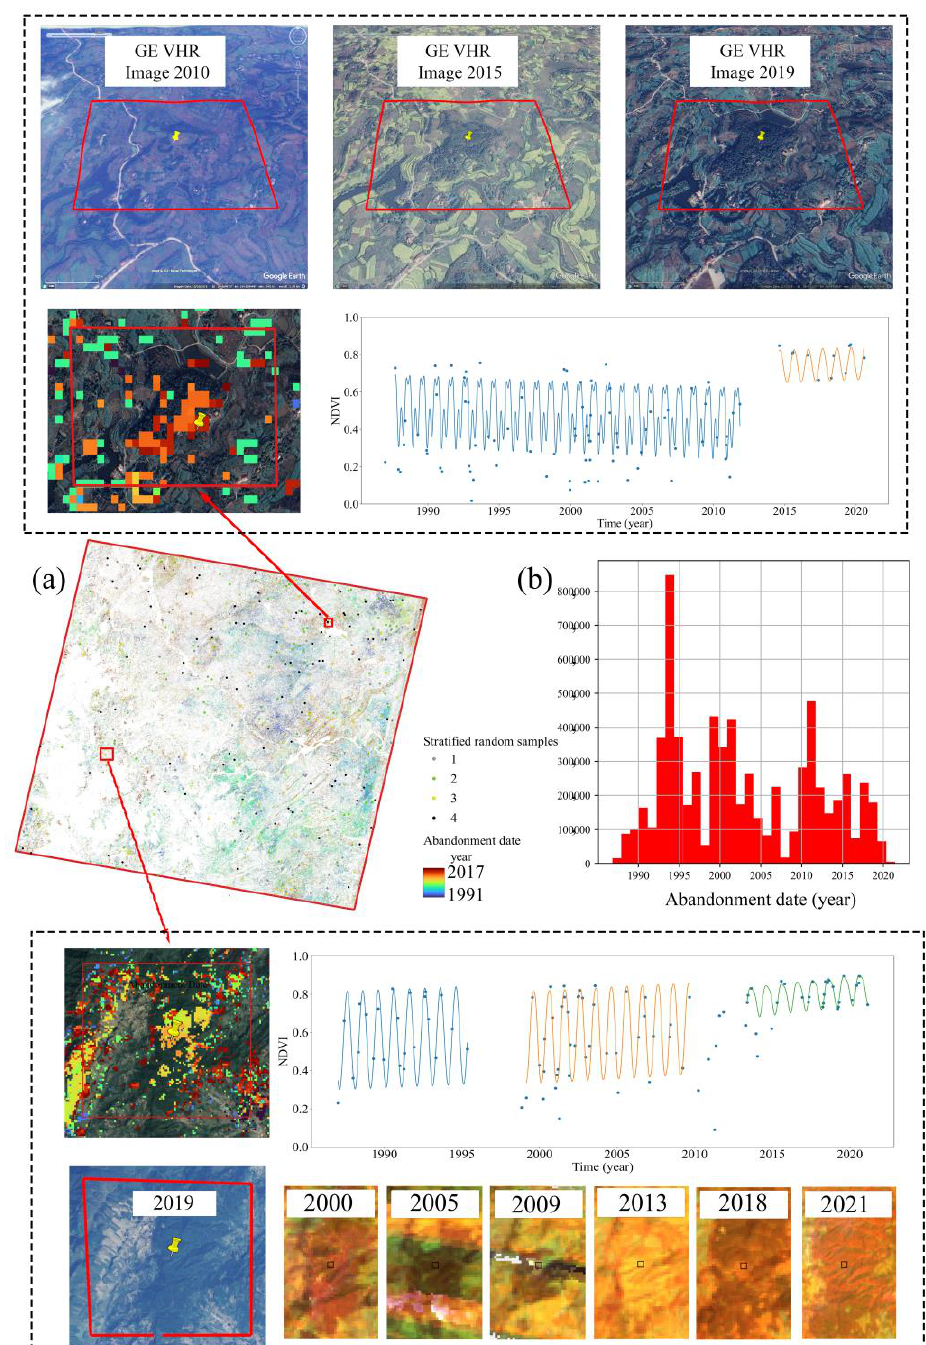
Figure 10. ( a ) The spatial distribution of abandonment time, over which the stratified random samples are laid for validation, and ( b ) the temporal distribution of abandonment time. The upper and bottom images in the dotted square show a zoomed-in view over abandoned croplands in hilly and mountainous regions, respectively. Next to these are the raw values of NDVI, overlaid by the fitted harmonic functions. Above and below these are the reference satellite images. As croplands in the upper images were abandoned around 2011, VHR images in Google Earth, capturing the abandonment, are shown. In contrast, as croplands shown in the lower images were abandoned in 2009, there were no VHR images to prove their active cropland status; thus, Landsat-7 images were used. Displayed in false colour in varied band combinations of NIR-SWIR-red, highly vegetated areas will be shown as different shades of red/orange, the less vegetated areas (open forest and grasslands) as shades of orange/yellow, and areas of very little vegetation as shades of green/blue.